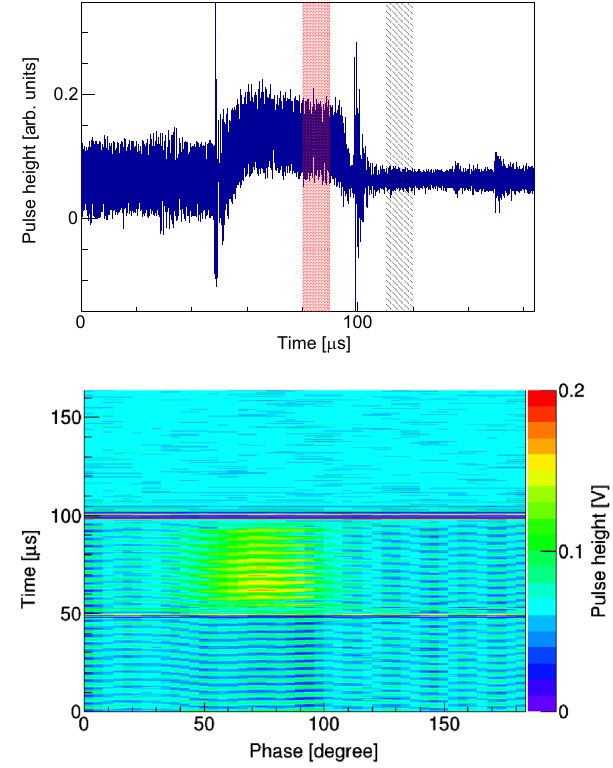
FIG. 7. Typical raw signal waveform from secondary-electron multiplier after preamplifier (top) and raw signal waveform distribution of longitudinal bunch-shape measurement (bottom) obtained using HOPG-BSM. The size of the HOPG target was 0 . 2 × 1 . 0 mm 2 . Sharp peaks around time 50 and 100 μ s are noise due to the H − ion beam. In the top plot, the red hatched and black hatched regions represent the signal and baseline regions, respectively, used for evaluating longitudinal phase distribution.